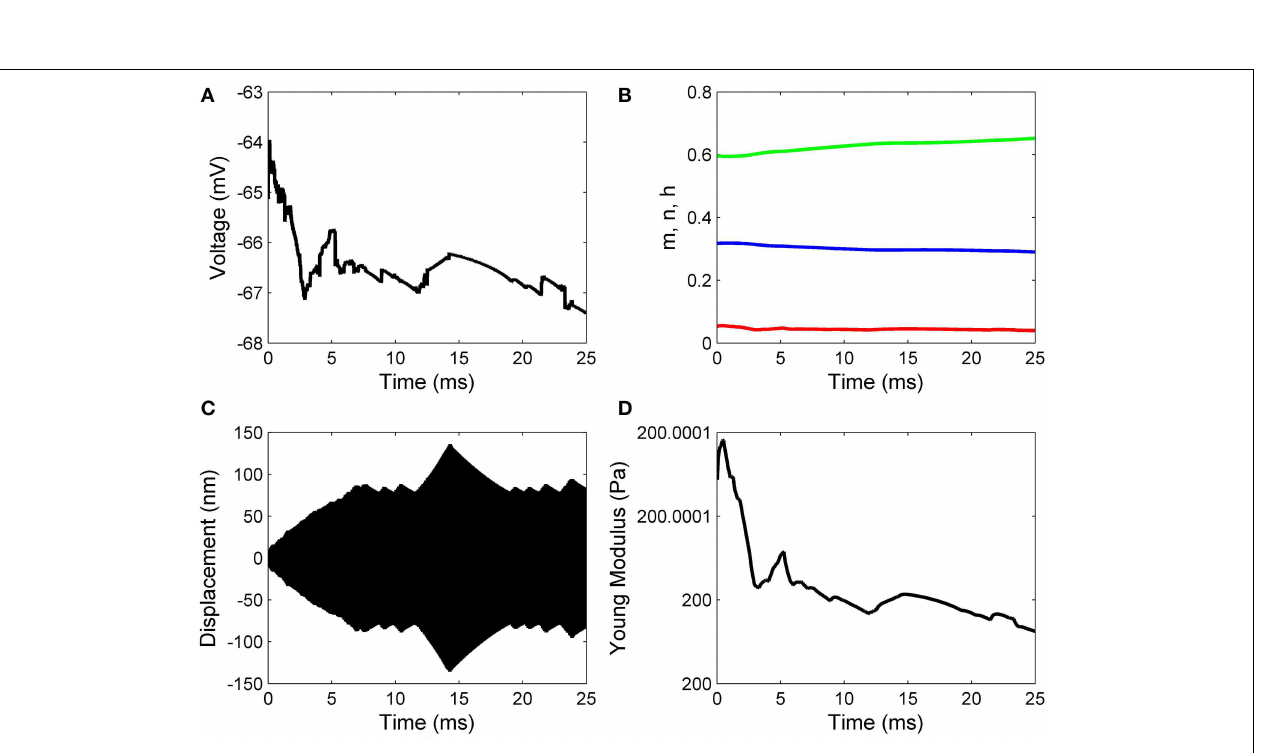
Frontiers in Cellular Neuroscience |